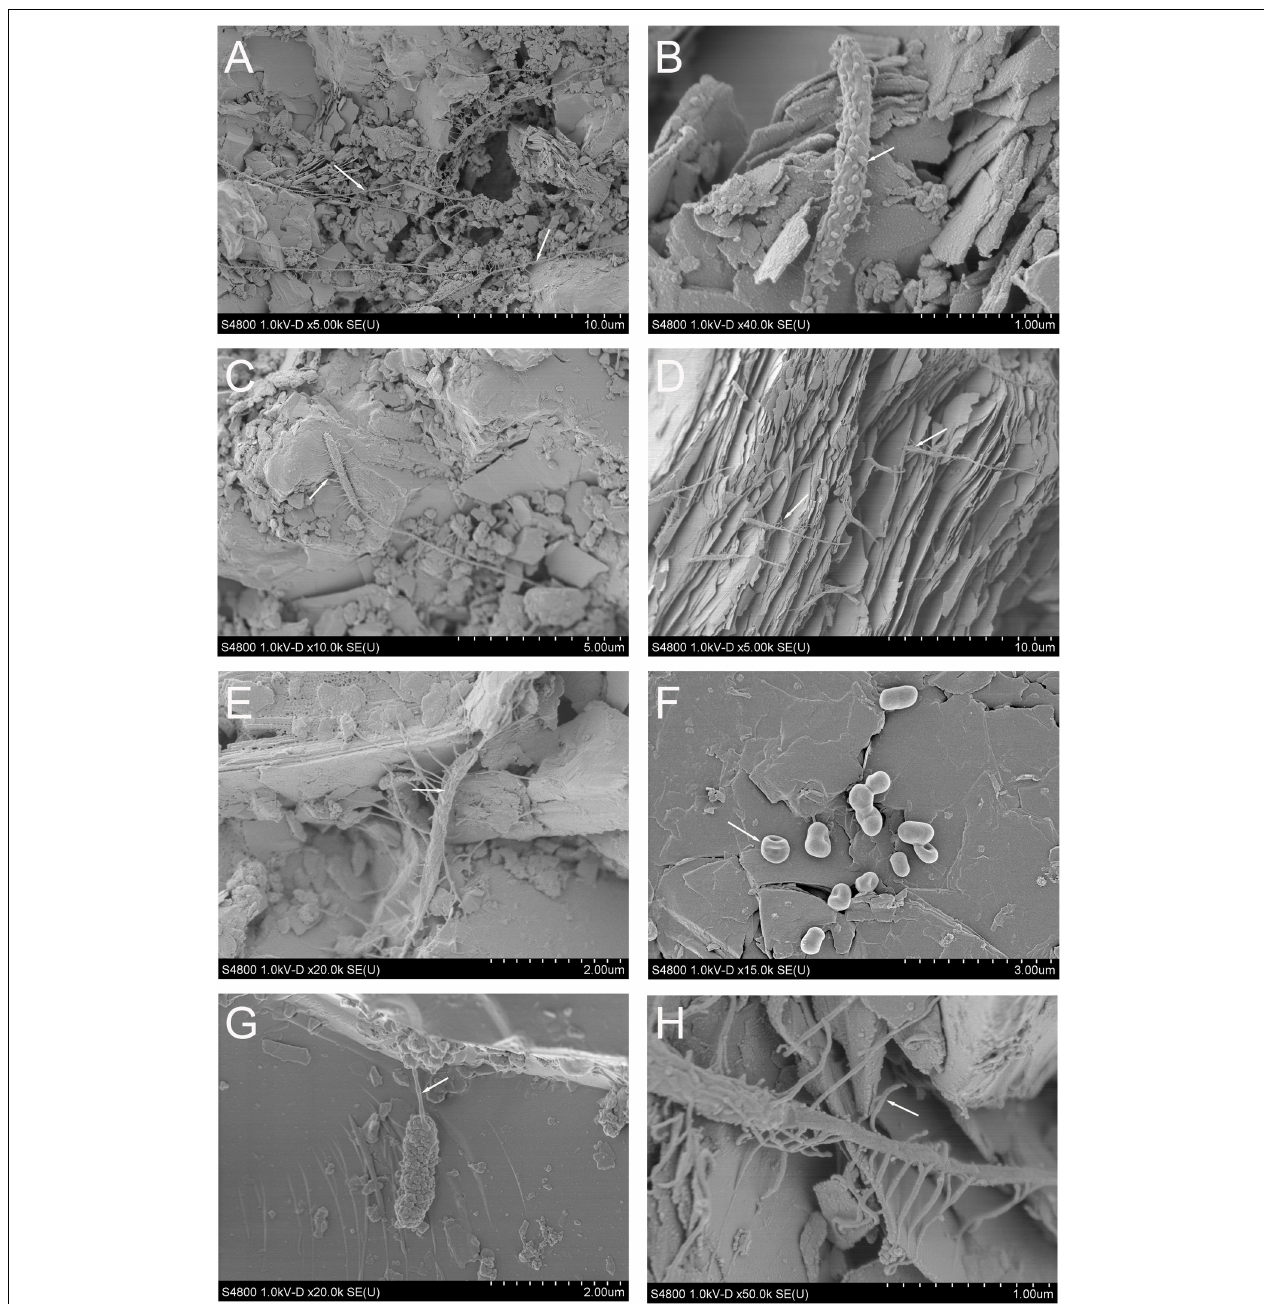
FIGURE 1 | (A–H) Scanning electron microscopy images from the mica schist slides after 8 months of incubation. (A) Long tubular, attached microbial cell-like structures, (B) rod-shaped putative microbial cell with spherical surface attached structures resembling outer membrane vesicles, (C–E,H) putative mica schist surface attached microbial cells with hair-like appendices, (F) rod-shaped putative microbial cells, (G) rod-shaped putative cell with a nanotube-like